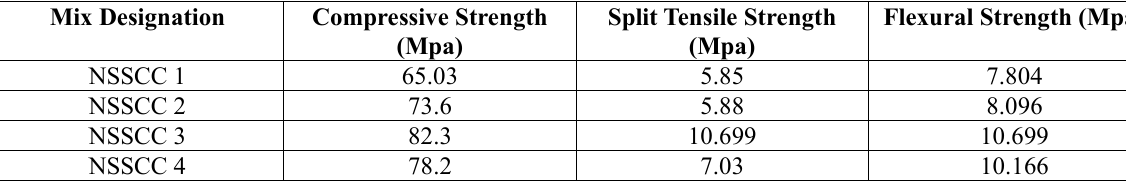
Mechanical Properties of Nano Silica.